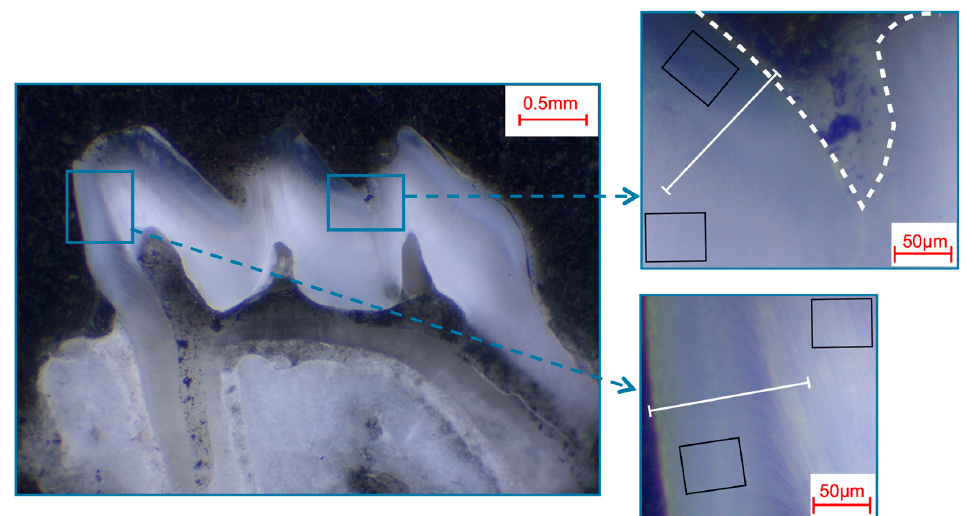
Figure 2. Selection of fields and line scans for the elemental analysis in murine first molars shown in a photo-microscopic overview. The white dashed line marks the enamel surface. The black squares indicate the areas of the 49 µm × 39 µm field scans, while the white lines indicate the approximately 140 µm paths of the line scans. The upper right picture shows the fissure area, while the bottom right picture shows the approximal area.